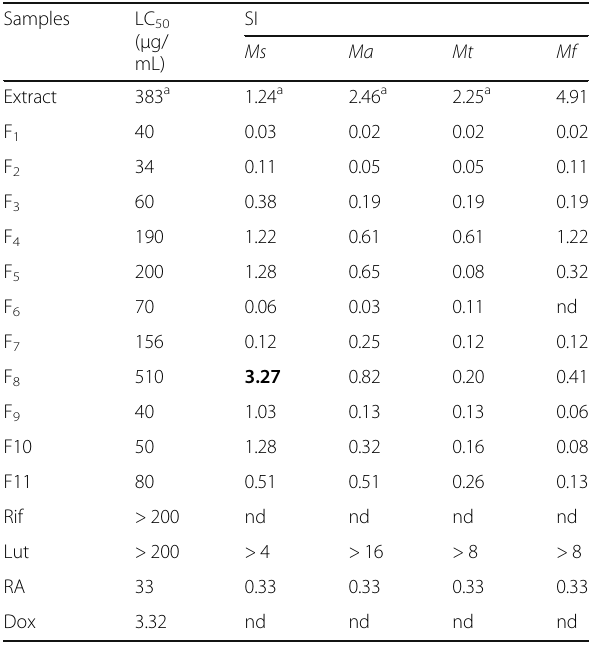
Table 3 LC 50 (against C3A liver cells) and selectivity index (SI) values of extract, fractions and compounds of Oxyanthus speciosus Samples